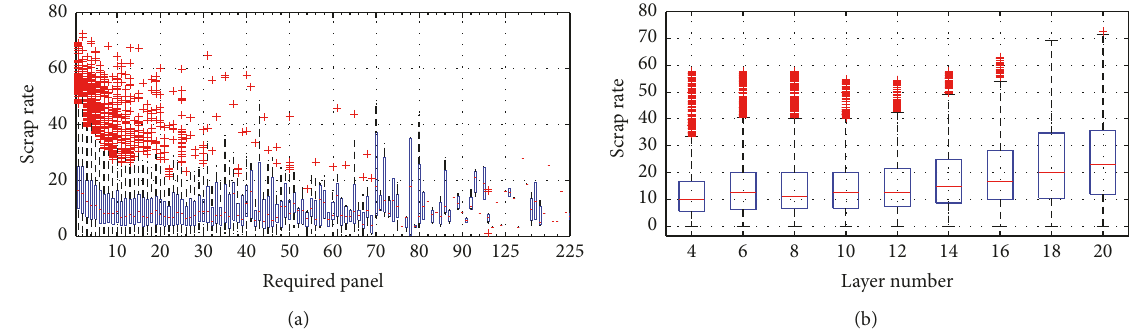
Figure 7: (a) Boxplot for different value of required panel. (b) Boxplot for different value of layer number.